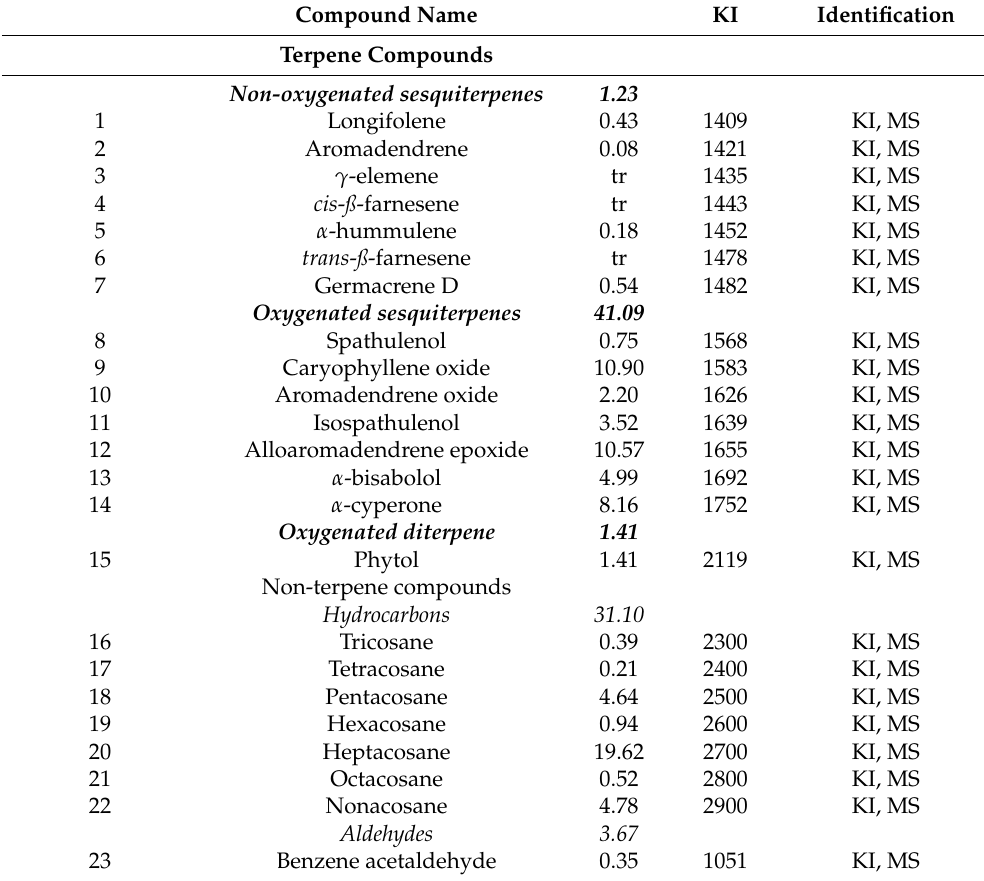
Table 1. Chemical composition and chemical class distribution of the essential oil of Centaurea scabiosa L. Compound Name KI Identification Terpene